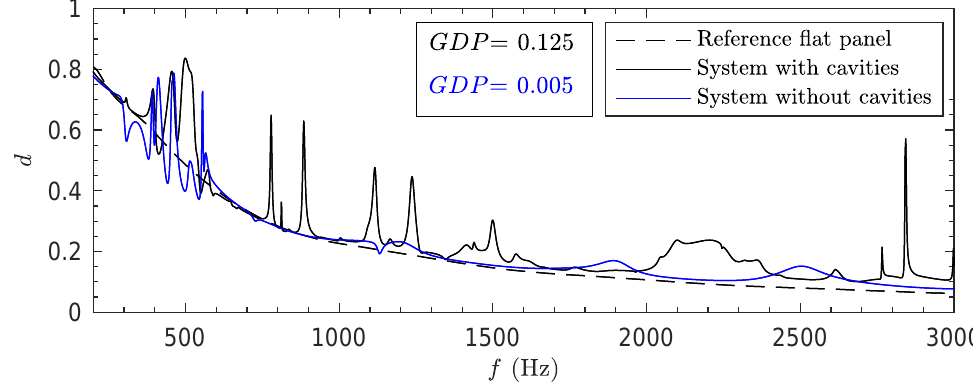
Figure 7. Diffusion coefficient of the proposed system of Helmholtz resonators with cavities compared to the one obtained for a system of 5 Helmholtz resonators without cavities optimized for maximum absorption at the same range of